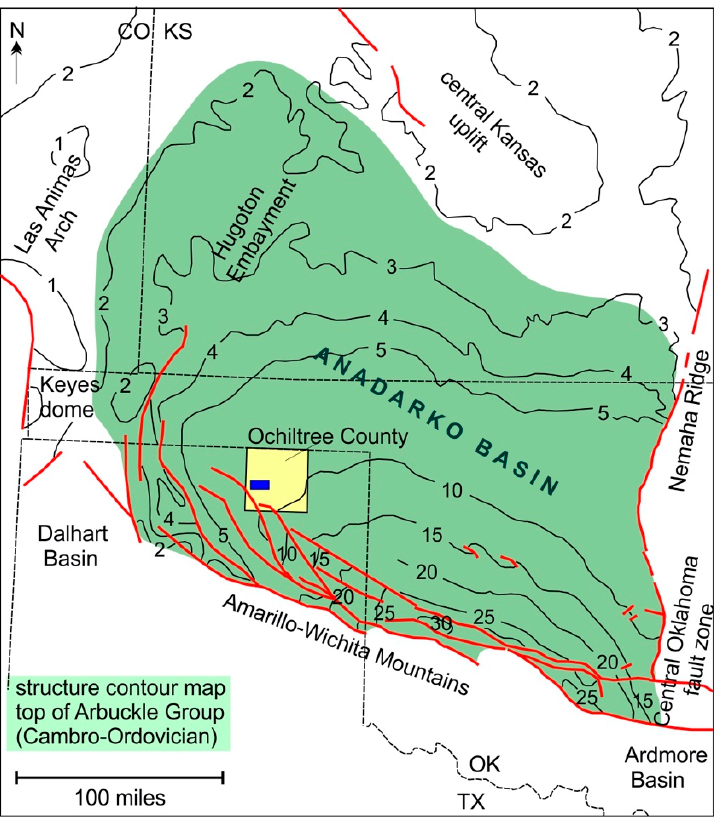
Figure 3. Anadarko basement structure map with major basin bounding faults and tectonic provinces (from Gragg [38], modified from Davis and Northcutt [39]). Contour intervals are in thousands of feet. Blue square is approximate location of FWU northwest of the deepest portions of the basin.